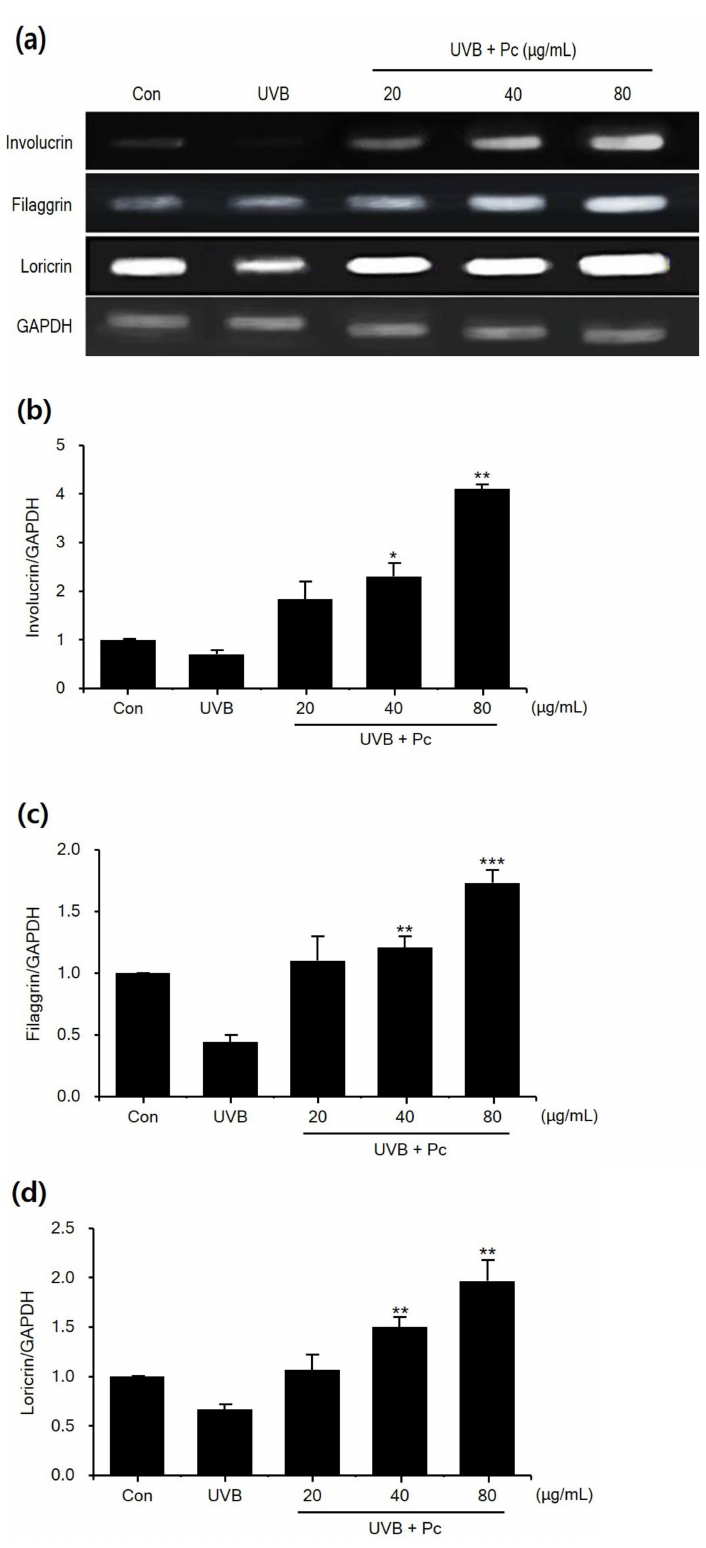
Figure 4. Effects C-phycocyanin (C-PC) on ( a ) western blot band ( b ) involucrin, ( c ) filaggrin, and ( d ) loricrin levels in ultraviolet B (UVB)-induced HaCaT cells, as assessed using Western blot analysis following treatment C-PC (20, 40, 80 µ g/mL) These results are representative of three experiments per- formed in triplicate. Band intensities were quantified, and data are presented as the mean ± standard deviation. * p < 0.05, ** p < 0.01, and *** p < 0.005 vs. UVB/vehicle